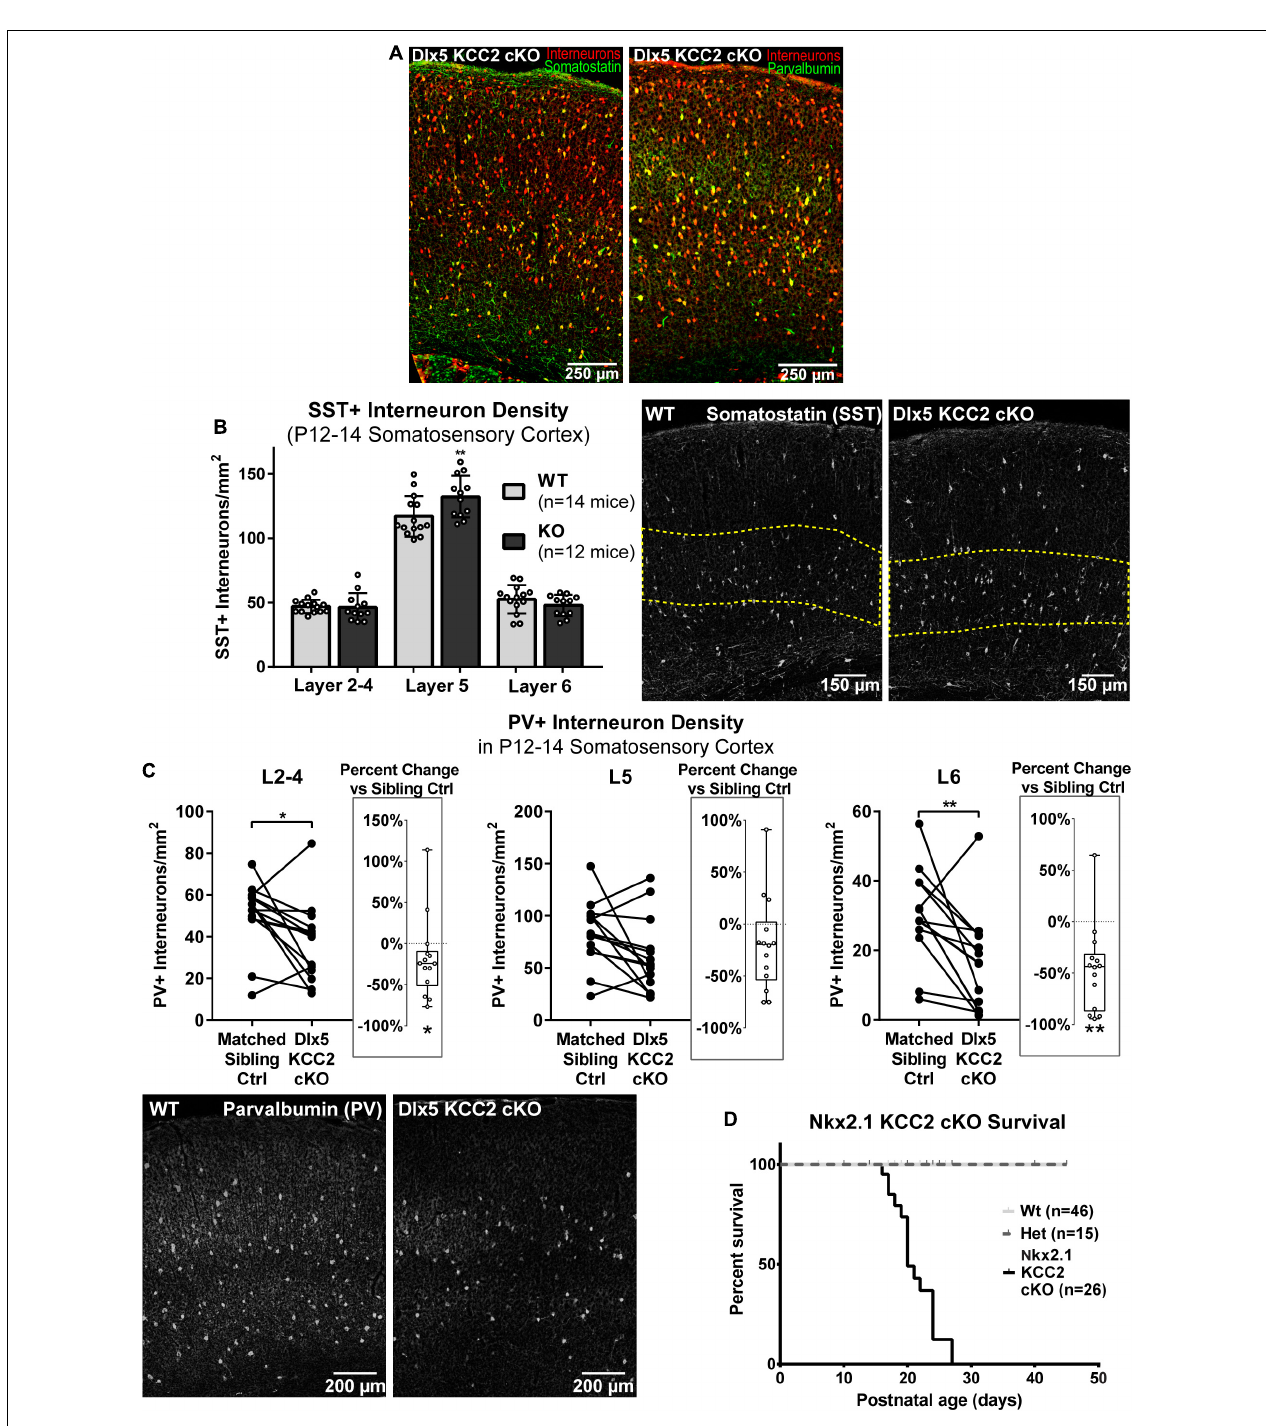
FIGURE 7 | Altered distribution of somatostatin and parvalbumin INs in maturing cortex of Dlx5 KCC2 cKO. (A) Images showing complete co-localization of SST (left, green) and PV (right, green) immunopositive neurons with Ai14 cre reporter used to label INs (red) in P13 barrel field cortex. (B) Average density with SEM of SST+ cells in different layers of P12–14 somatosensory cortex with exemplary images of SST immunolabeling. Yellow dashed line demarcates layer 5. n = 14 WT, 12 Dlx5 KCC2 cKO mice. One-way ANOVA with Sidak’s multiple comparisons: ** P < 0.01. (C) Paired comparisons of density of PV+ cells in layers 2–4 (L2–4), 5 (L5), and 6 (L6) in P12–14 somatosensory cortex of Dlx5 KCC2 cKO and control littermates, with exemplary images of PV immunolabeling. Box and whisker plots in each graph plot percent difference change in each littermate pair, n = 12 littermate mouse pairs. Wilcoxon matched-pairs signed rank test, ** P < 0.01, * P < 0.05. (D) Survival plot of Nkx2.1 KCC2 knockout, conditional only to PV and SST INs. n = 46 WT, 15 heterozygote, 26 Nkx2.1 KCC2 knockout mice.